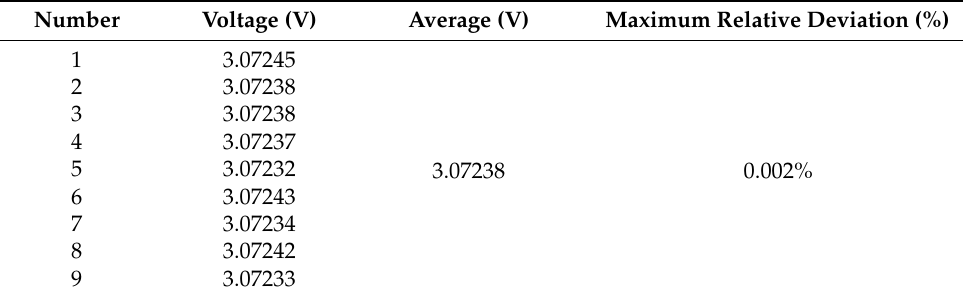
Table 2. Voltage fluctuation of LED light source in Experiment 1.